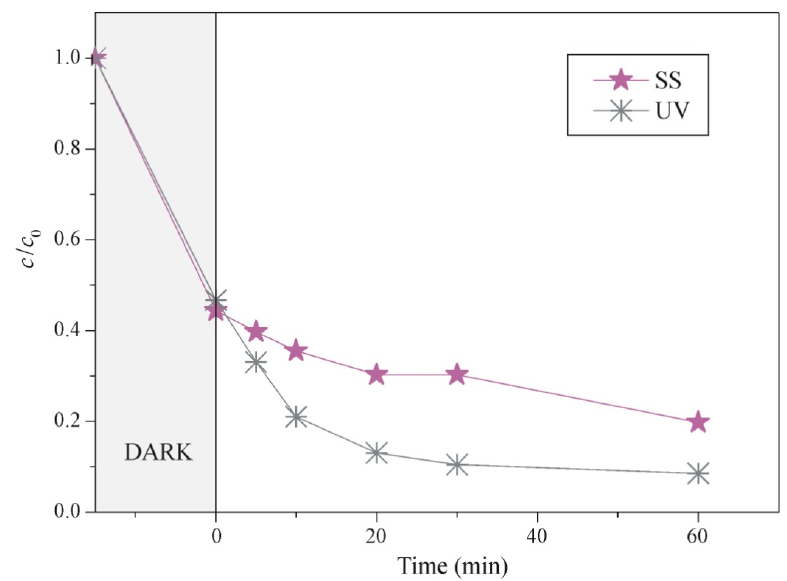
Figure 6. Effect of radiation type on the efficiency of CIP (0.05 mmol/dm 3 ) removal using a TMO (1.0 mg/cm 3 ) photocatalyst without pH setting (pH 5.5).